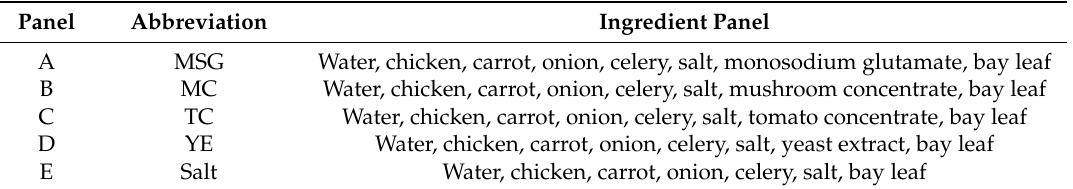
Table 2. Ingredient lists of chicken soup samples used in consumer